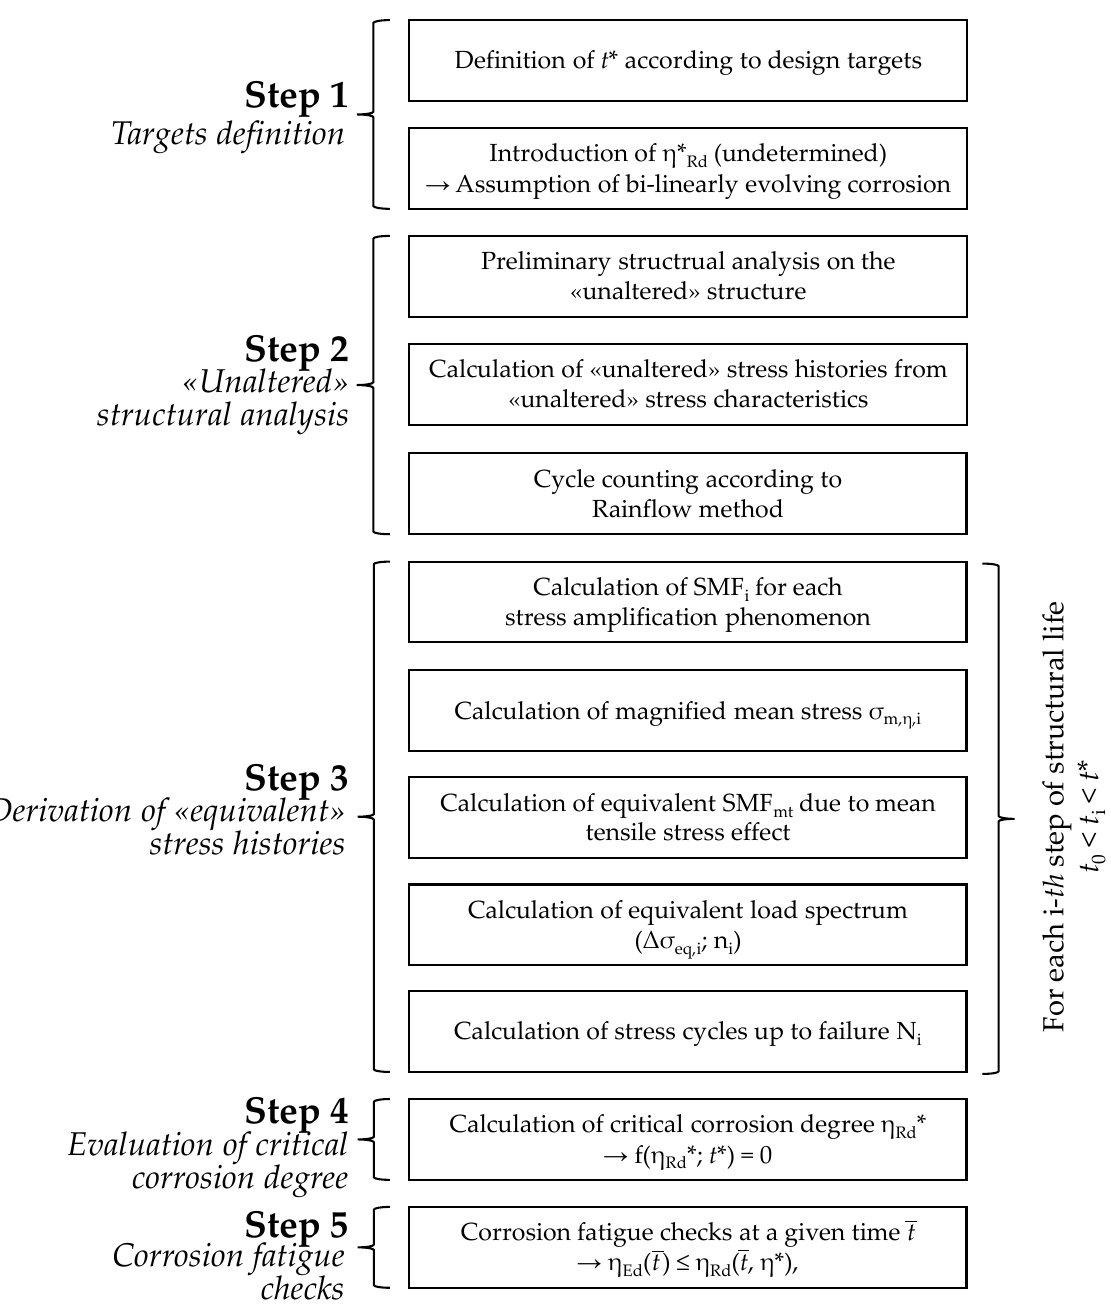
Figure 1. Articulation of the proposed methodology for the fatigue assessment of steel structures in aggressive environments.